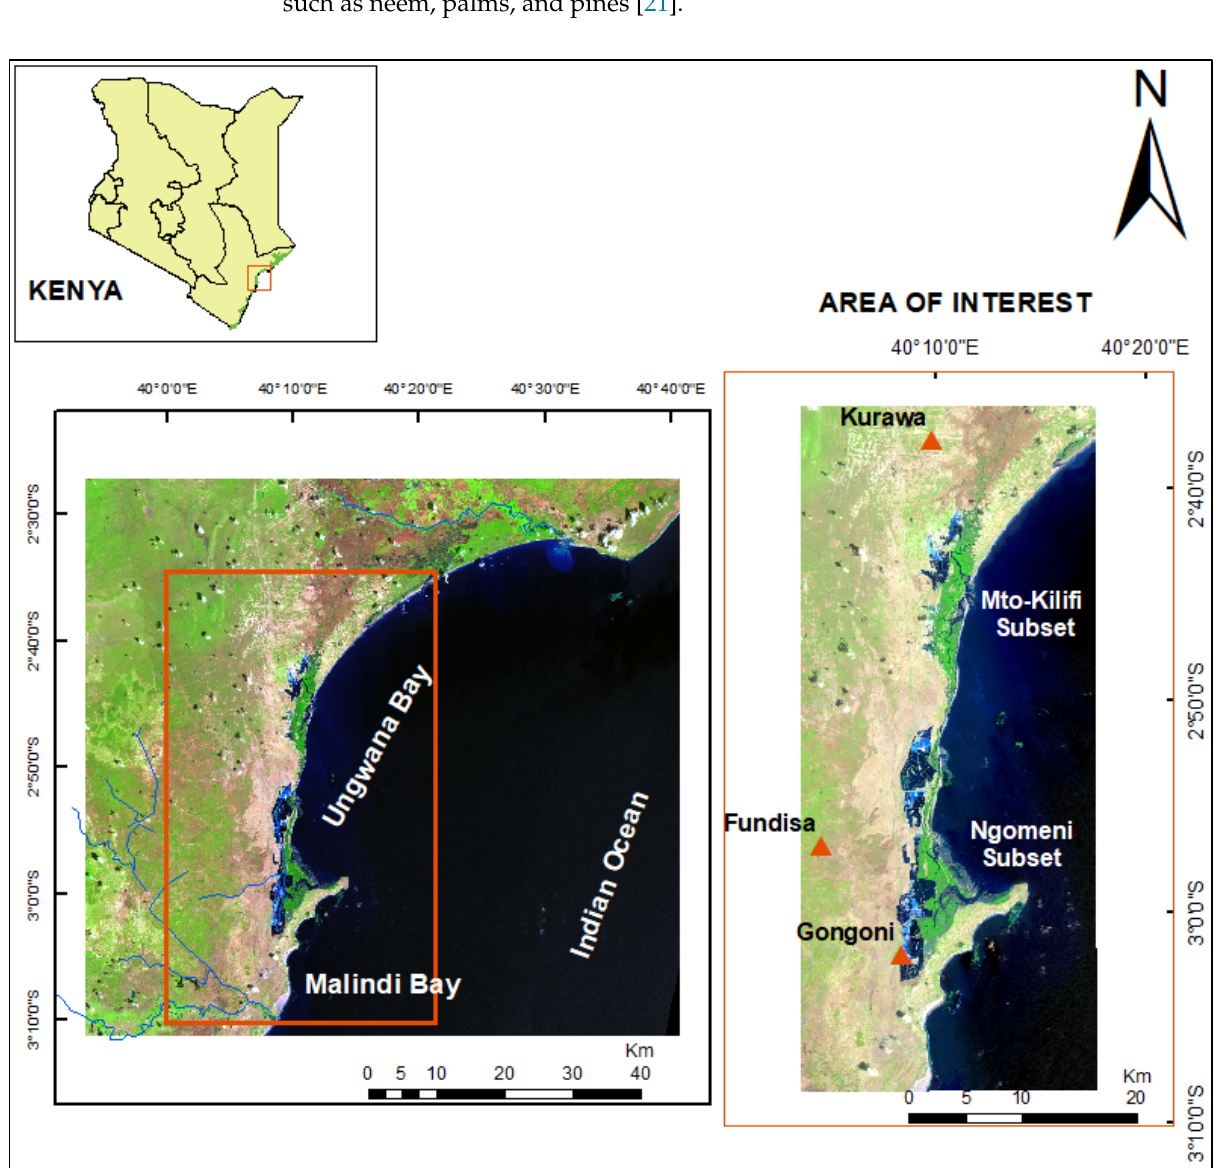
Figure 1. The geographic location of the study area and the area of interest (red triangles) on the North coast of Kenya (Source: Landsat-8 image courtesy of the U.S. Geological Survey).